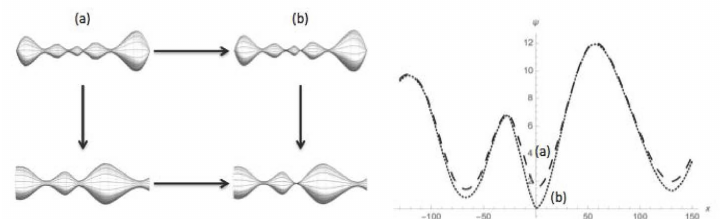
Figure 11. This is an illustration of the dimpled dumbbell. The three-dimensional surfaces (above) are the plots of the dumbbell on the interval [ − 100 π + 0.1,100 π − 0.1 ] and close-ups of some of the necks, including the most-pinched neck, on the interval [ − 130,150 ] at initial time t = 0 ( a ) and final time t = 1.1599 ( b ). The initial (long dash) and final (short dash) radial profiles are plotted below on the interval [ − 130,150 ]